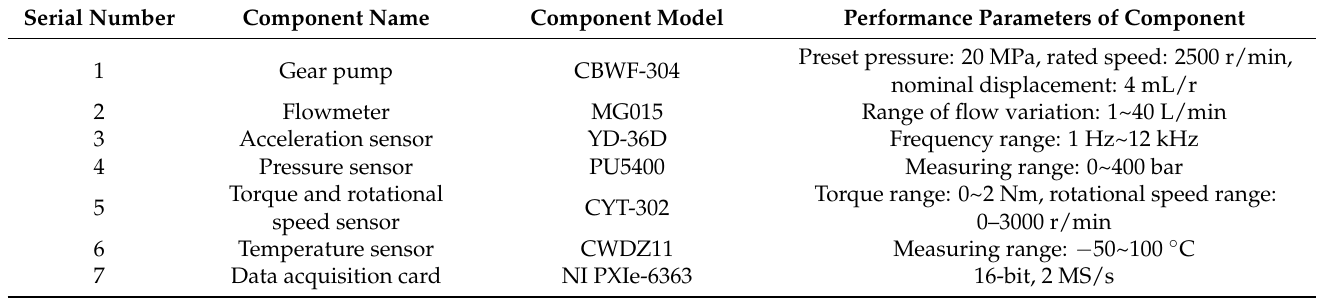
Table 3. The models and performance parameters of the main components of the test bed.